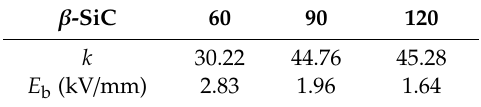
Table 5. The non-linear coefficient k and the threshold field E b of the samples with different β -SiC